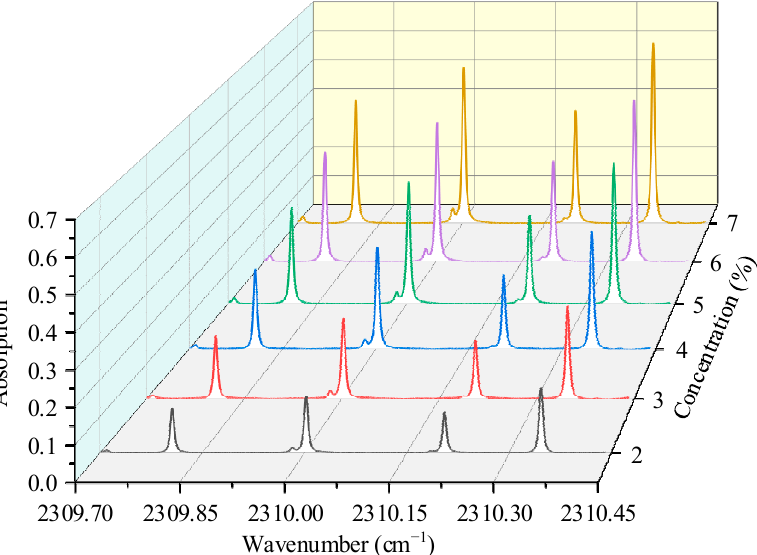
Figure 7. Measured absorption signals of CO 2 stable isotopes with a total concentration of 2%–7%.